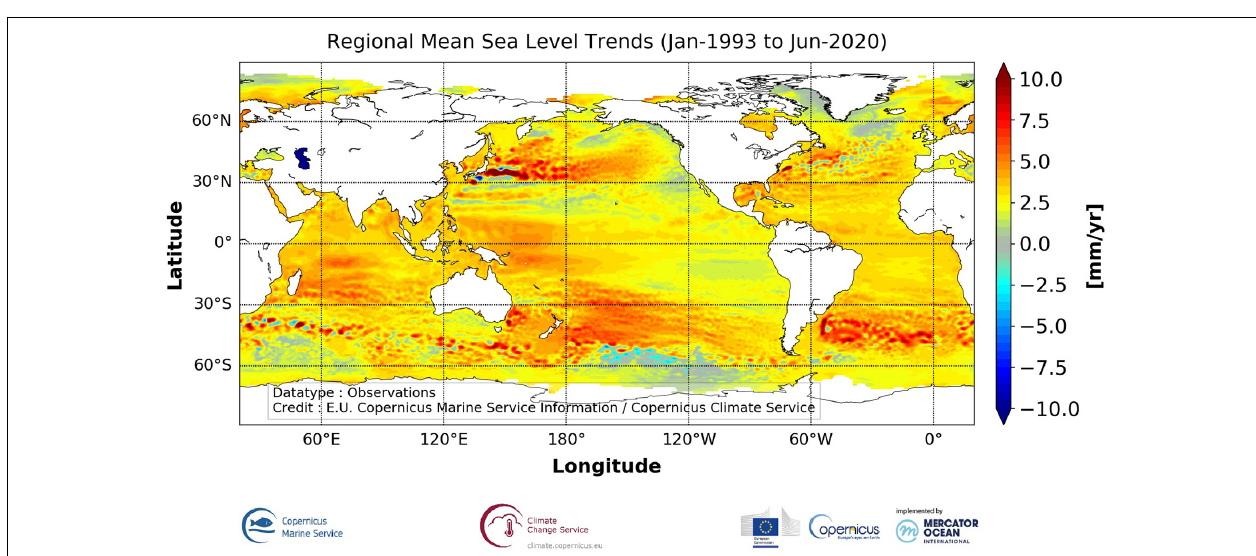
FIGURE 7 | Global Mean Sea Level derived from the altimeter C3S multi-mission gridded sea level product (DUACS vDT2018) from January 1993 to June 2020. The global average is derived from box-averaged gridded sea level maps weighted by the cosine of the latitude. The timeseries is low-pass filtered, the annual and semi-annual periodic signals are adjusted. The curve is corrected for TOPEX-A instrumental drift during 1993–1998 (WCRP Global Sea Level Budget Group, 2018) and is corrected for the GIA effect. Quoted uncertainties are within a 90% confidence level (adapted from Ablain et al., 2019).